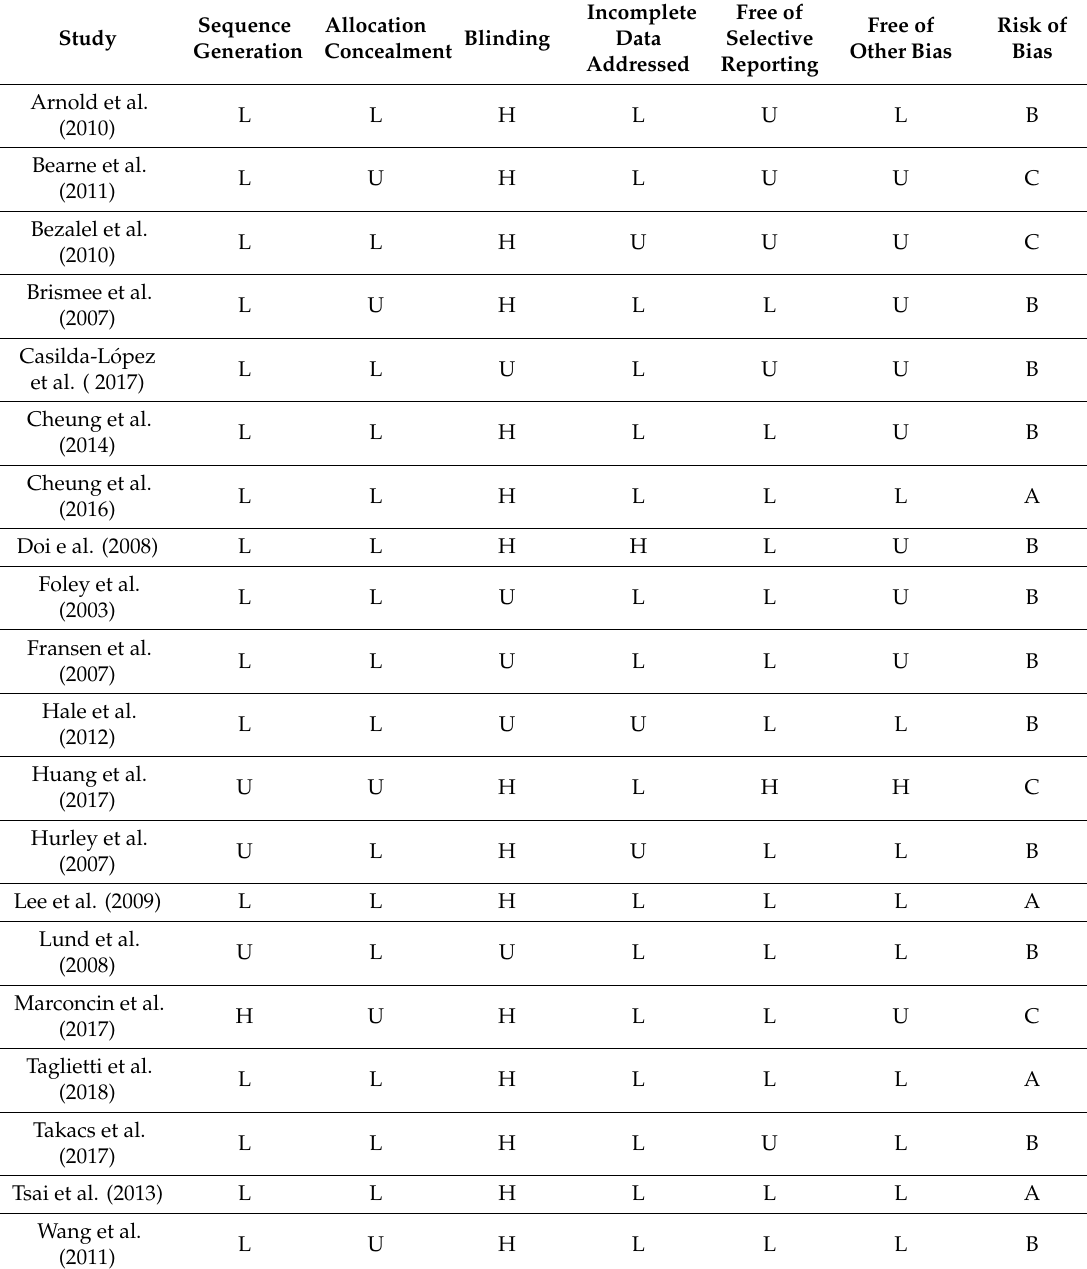
Table 3. Cochrane risk of bias tool for randomized controlled